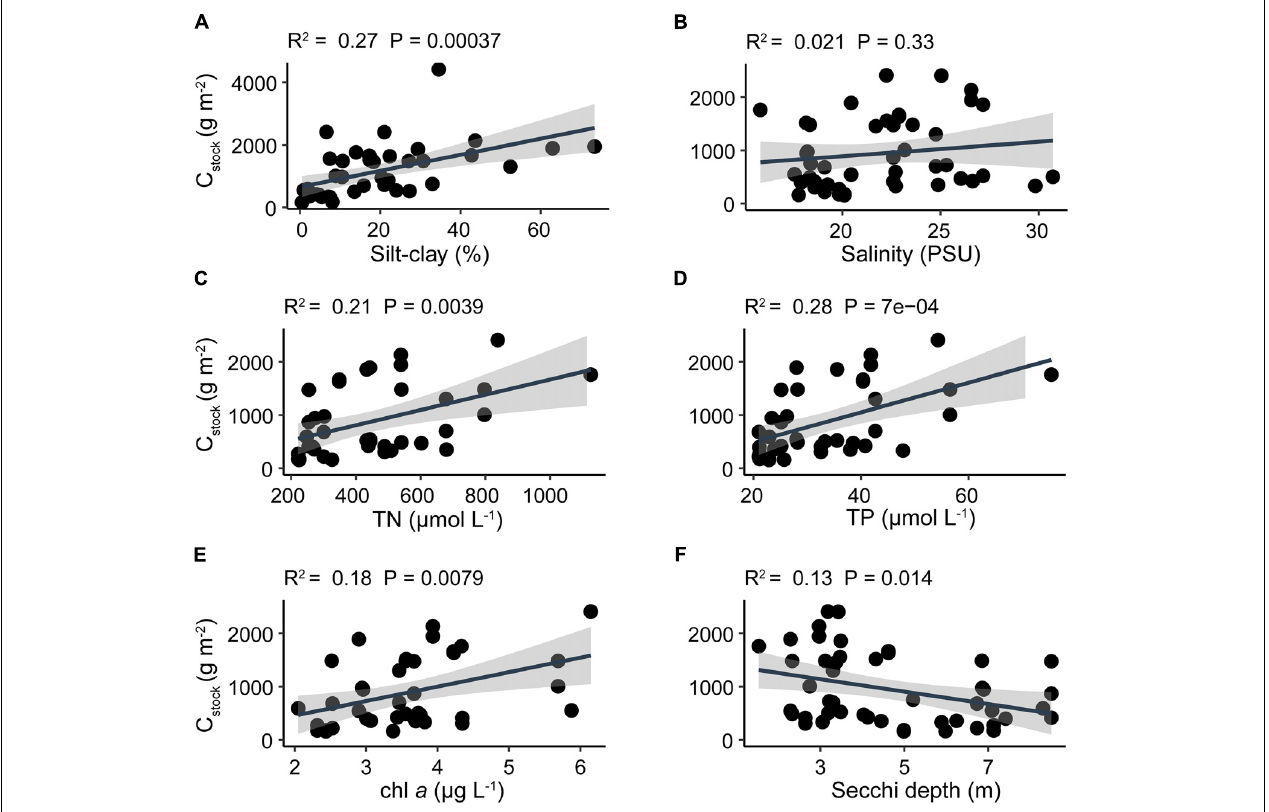
FIGURE 4 | Linear regression analyses of average C stock and (A) sediment silt-clay content, (B) water column salinity, (C) total nitrogen, (D) total phosphorus, (E) chlorophyll a , and (F) Secchi depth. Black solid line indicates the best fit line result of linear regression and shaded area indicates 95% confidence interval. Note that the y -axis limit in panel (A) is different from other panels. TABLE 1 | Summary table of generalized linear model